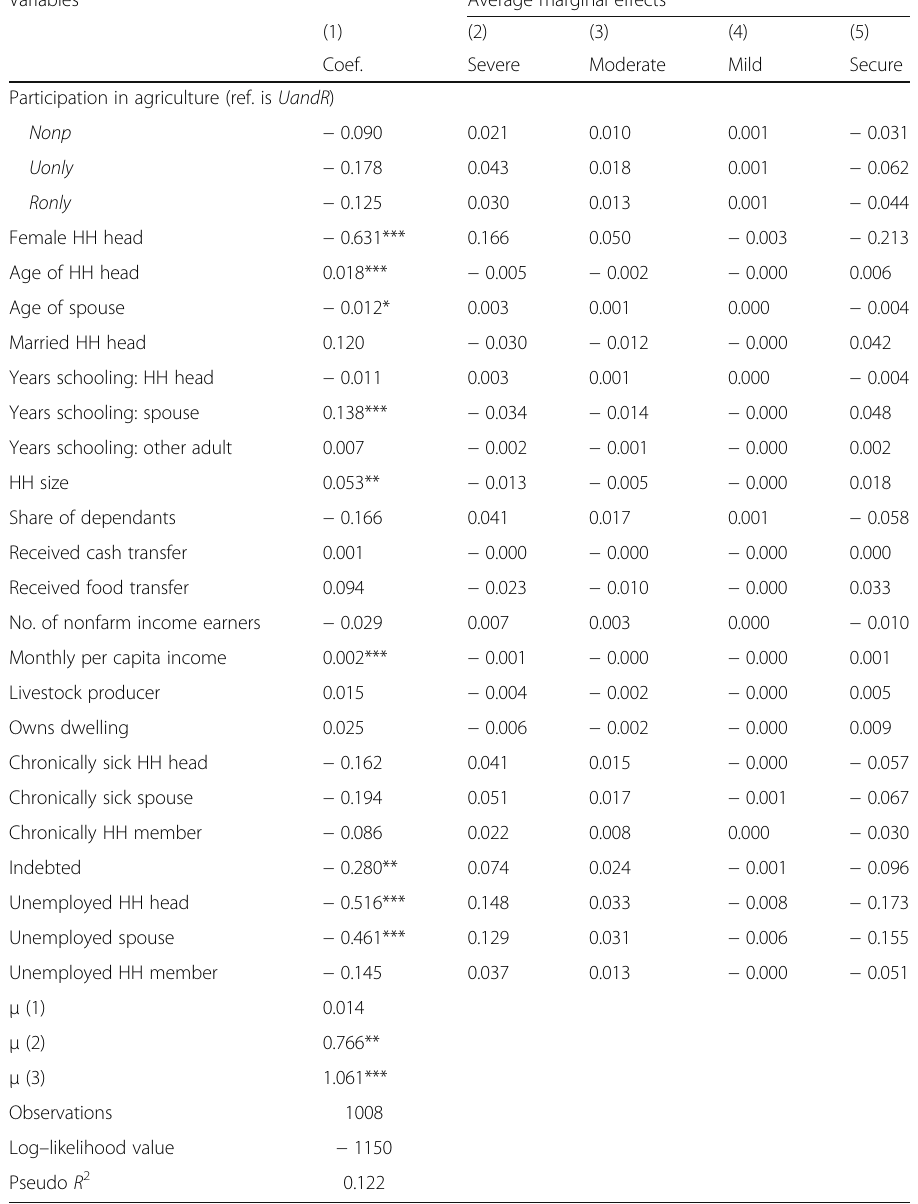
Table 5 Ordered probit estimates of participation in agriculture and food security (Techiman)